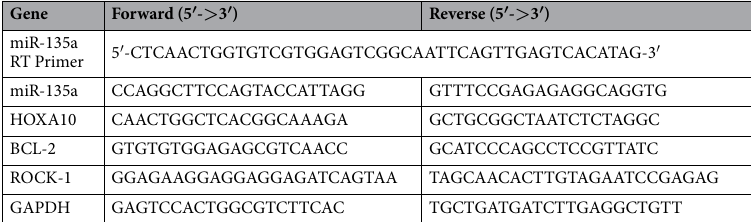
Table 1. Quantitative PCR primers sequence. Quantitative PCR primer sequences. U6 was used as an invariant housekeeping internal control gene for miR-135a, and GAPDH was used as an invariant housekeeping internal control gene for HOXA10, BCL-2, and ROCK-1.